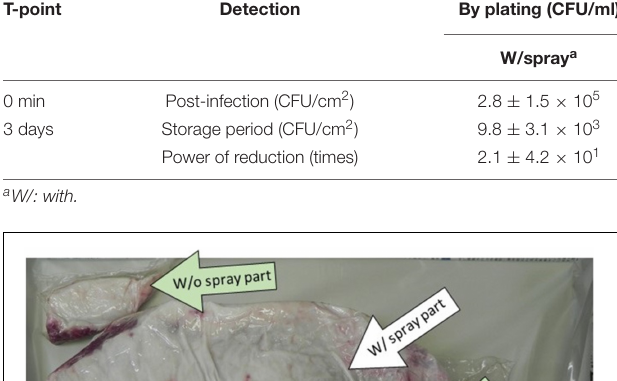
TABLE 4 | The effect of the spray method on the viability of EDL933 strain cells. T-point